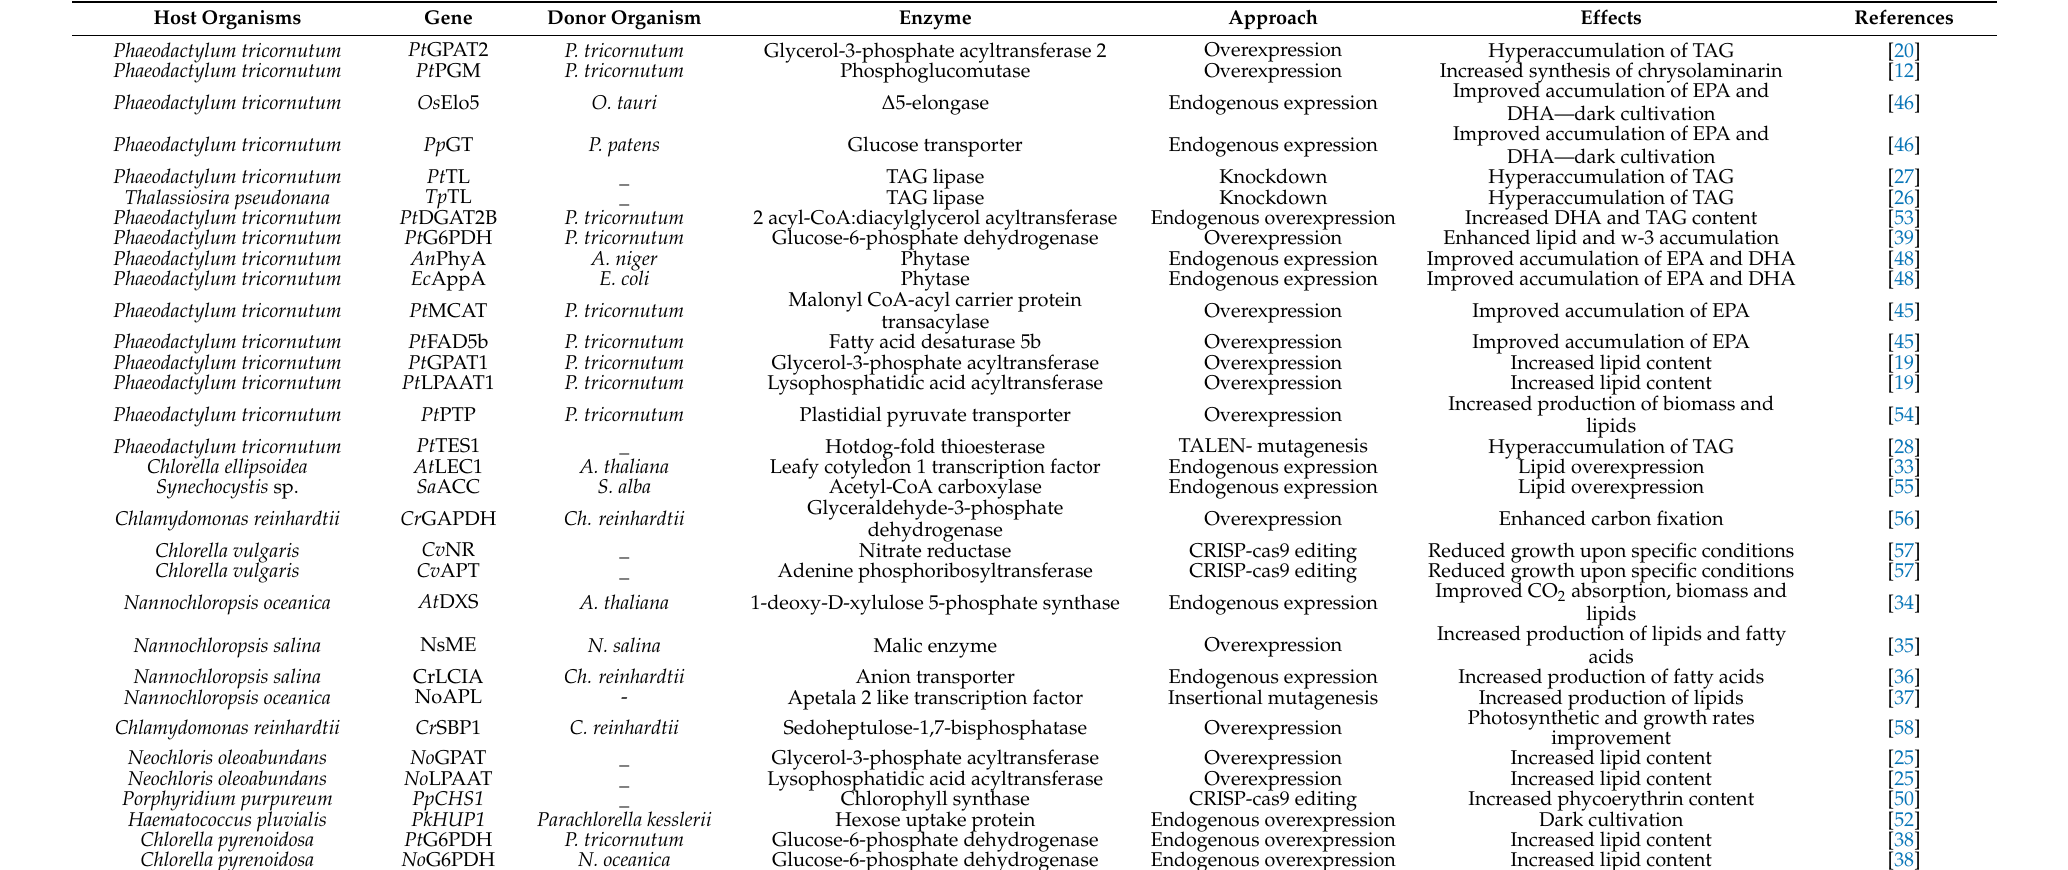
Table 1. List of microalgae engineered